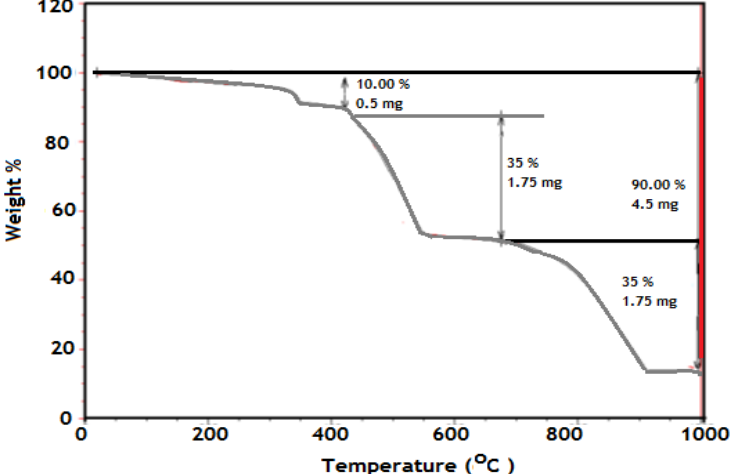
Figure 3. TGA thermogram of PAMPS-Na-co-St/magnetite